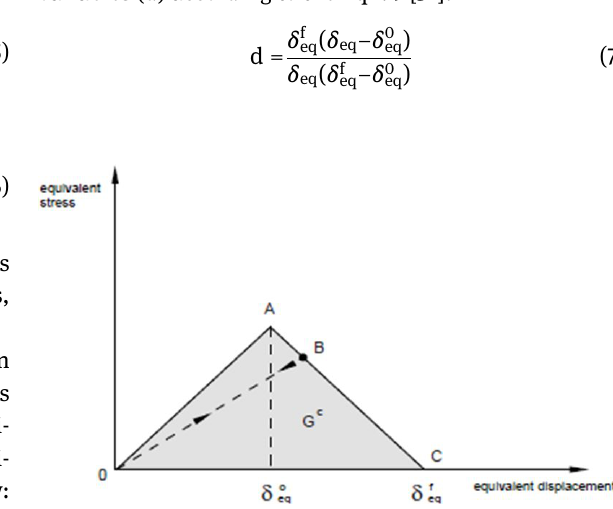
Fig. 2. Traction separation law